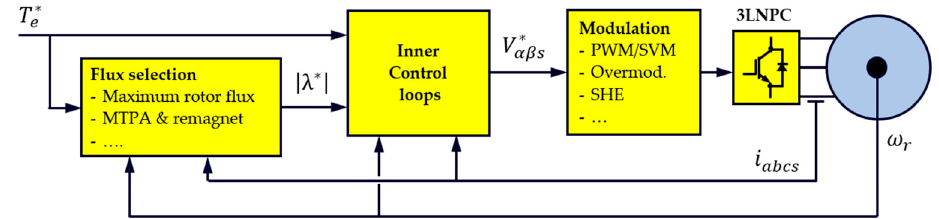
Figure 2. Main blocks of a traction drive.